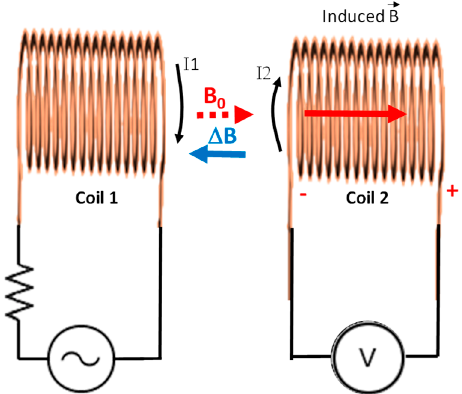
Figure 3. Principle of operation for our developed sensor.